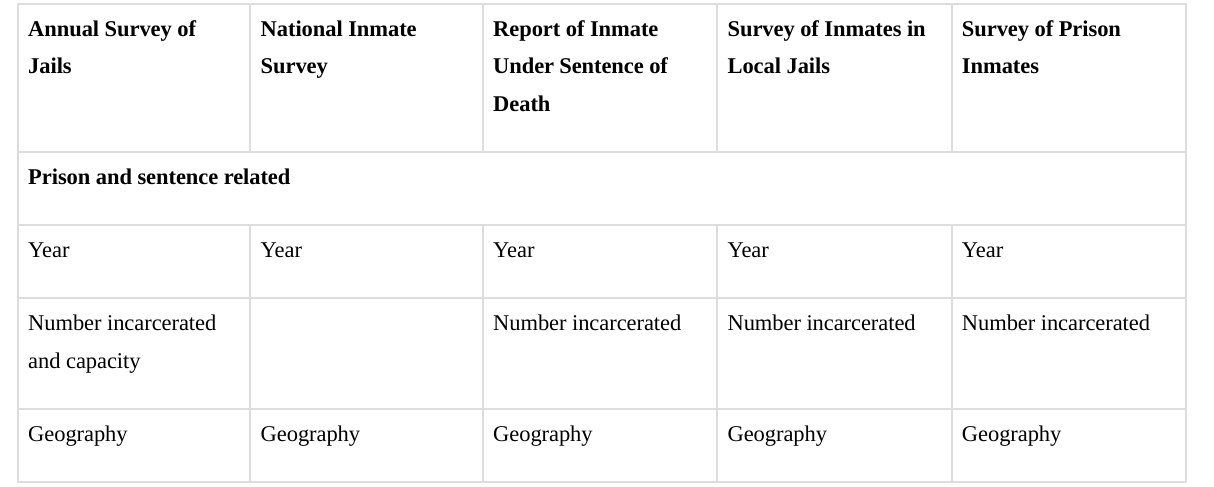
Table 3. Bureau of Justice Statistics “inmate” question